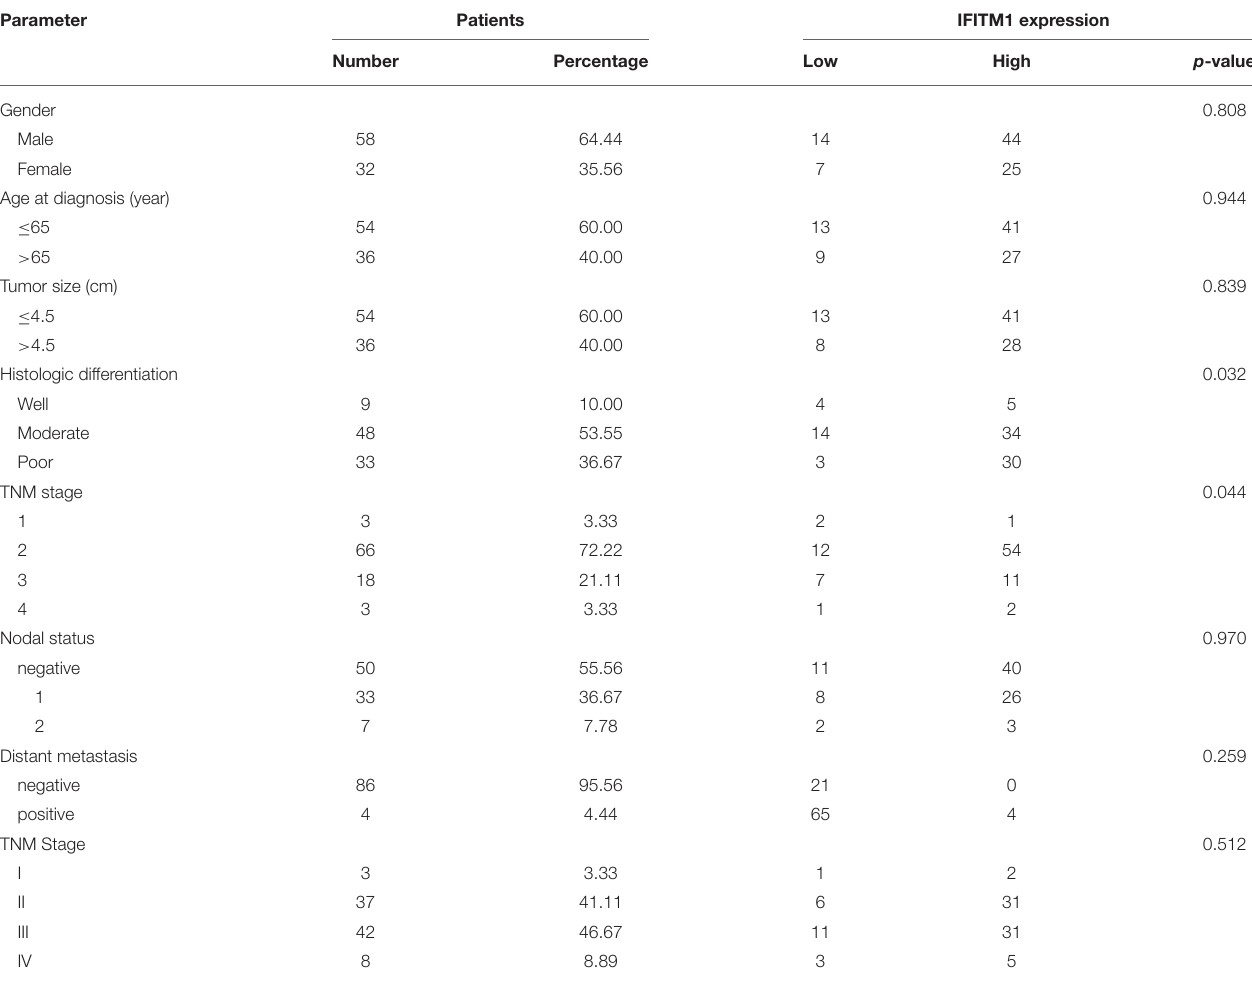
TABLE 3 | Relationship between the expression of IFITM1 and clinical characteristics of 90 patients with pancreatic cancer.